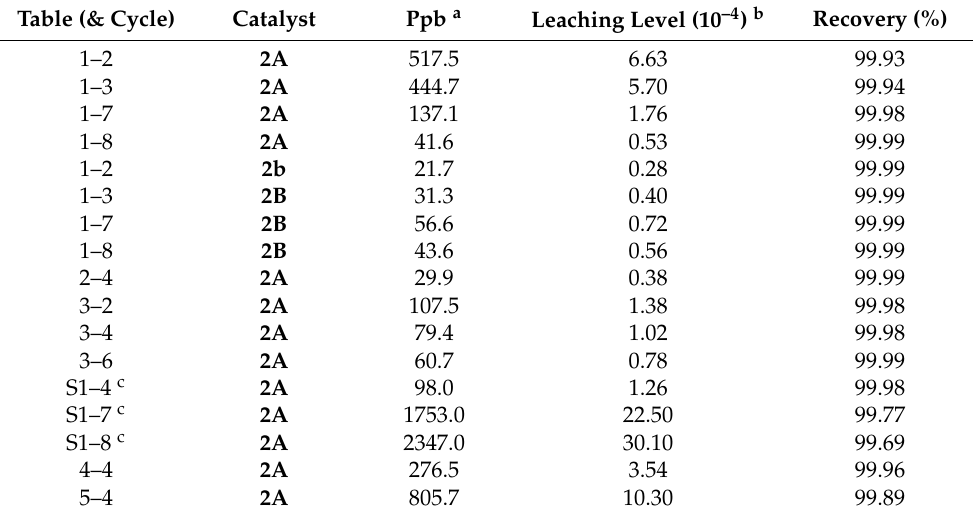
Table 6. Detection of platinum metal leakage by ICP-MS. Table (&